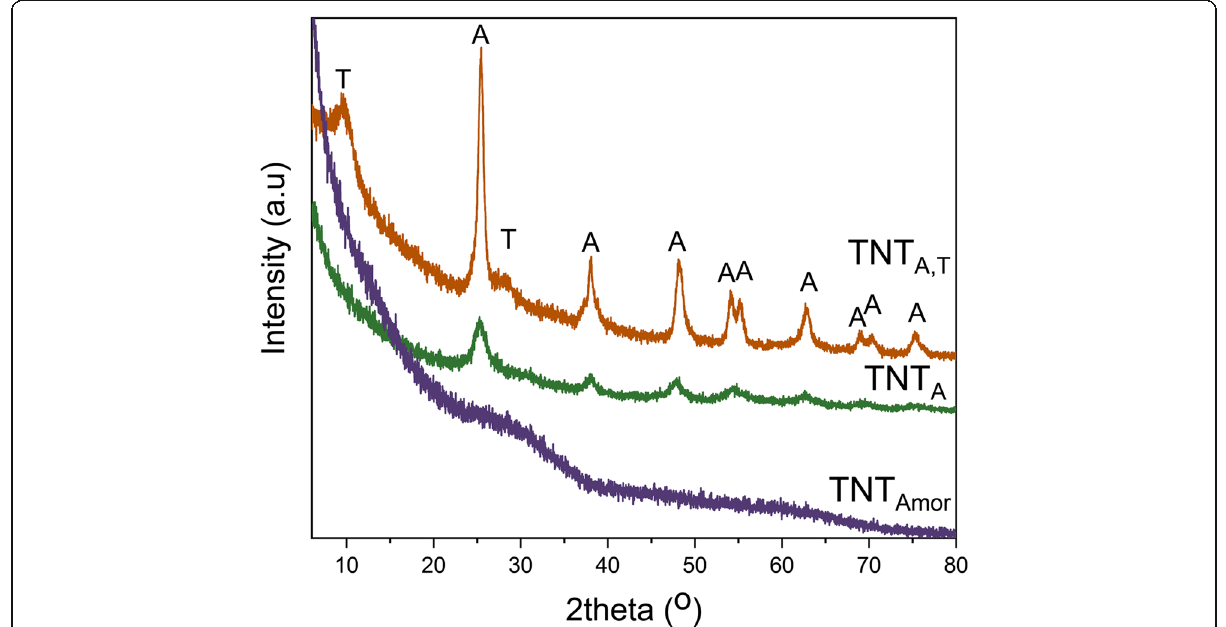
Fig. 2 XRD of crystalline titania nanotubes consisting of anatase (TNT A ), both titanate and anatase (TNT A,T ), and amorphous structure (TNT Amor ) [41, 42]. T = H 2 Ti 3 O 7 , A = anatase